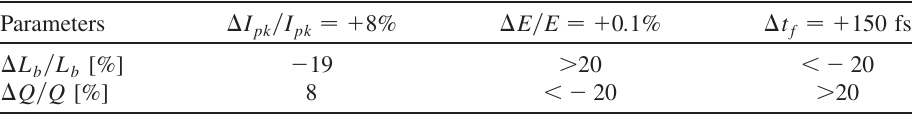
TABLE II. Individual sensitivities. Each parameter variation causes a (cid:1) I pk =I pk ¼ þ 8% relative peak current change, or a (cid:1) E=E bunch arrival time change after the bunch